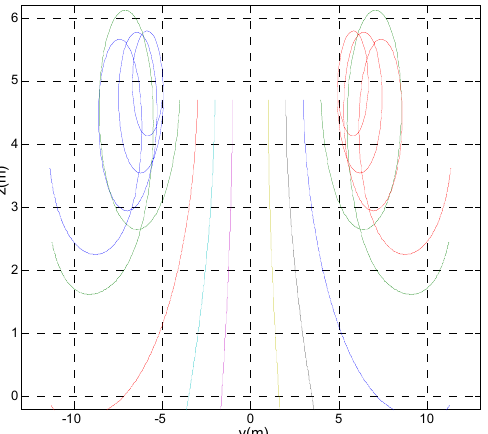
Figure 10. Mass fraction of droplet size distribution from 10 μ m to 670 μ m.